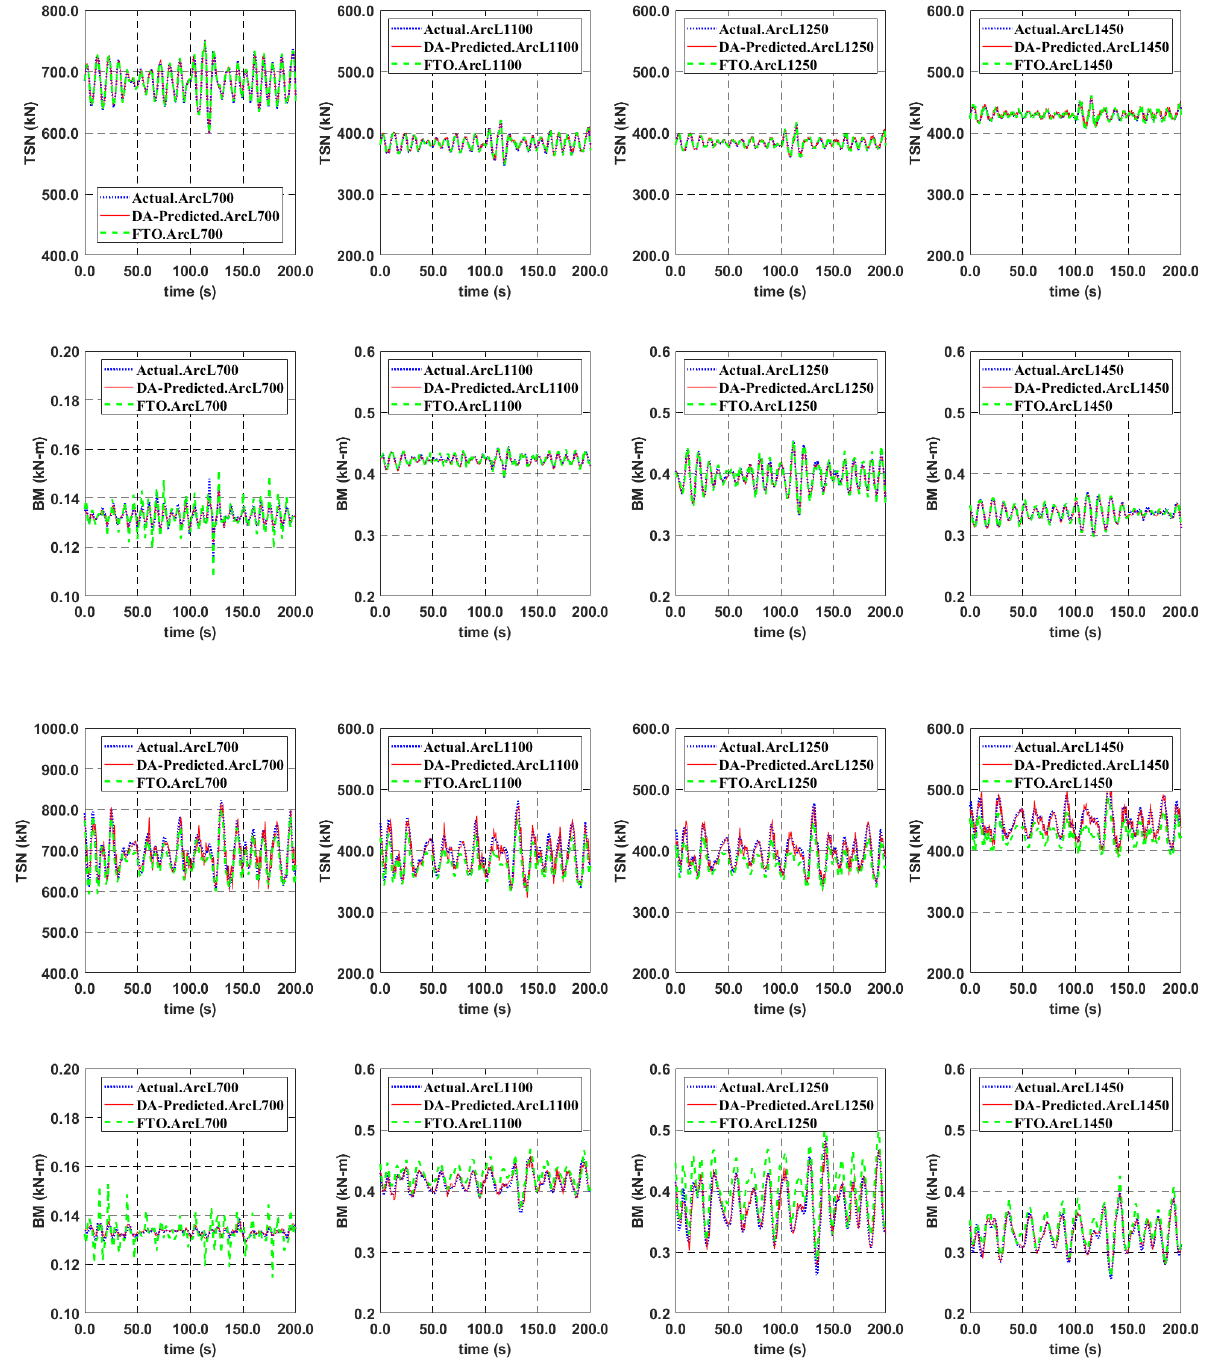
Figure 16. Structural-Health Monitoring Performance Near Touch Down Zone (= Arc Length 1200–1350 m) and Middle Part (700 m) by DA and FTO Approaches: 1-yr Storm ( Up ) and 100-yr Storm ( Down ), WD1000, SLWR, Sensors at 0 m, 100 m, and 200 m Arc Lengths Only.